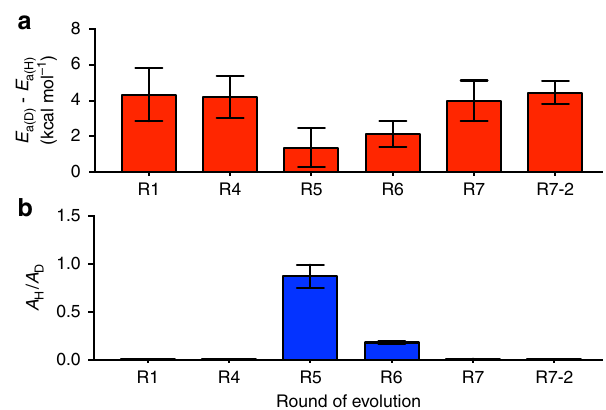
Fig. 5 Preorganization and primary kinetic isotope effects in KE07 evolution. Activation energy KIEs ( a ) and pre-exponential factor KIEs ( b ). Error bars denote propagated standard errors in the fi tted parameters to Arrhenius plot (Supplementary Fig. 11) from three independent